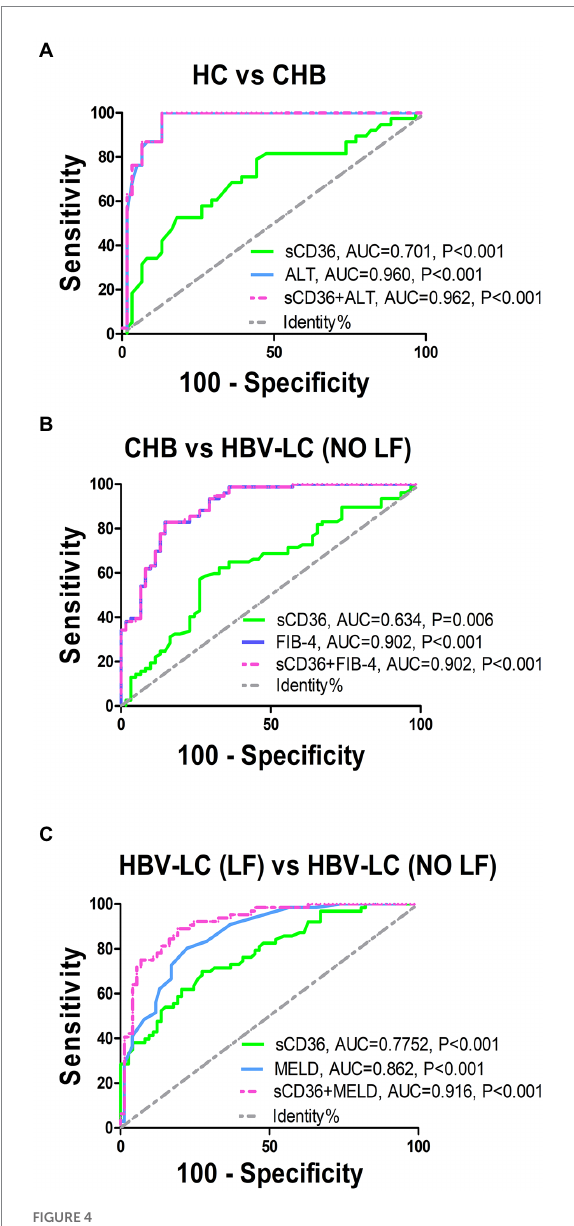
FIGURE 4 Discriminate validity of plasma sCD36 for HBV-related liver diseases with different stages. (A) ROC curves of plasma sCD36, ALT and their combination for discriminating CHB from HCs; (B) ROC curves of plasma sCD36, FIB-4 and their combination for discriminating HBV-LC (NO LF) from CHB; (C) ROC curves of plasma sCD36, MELD and their combination for discriminating HBV-LC (NO LF) from HBV-LC (NO LF); The Youden index was used to maximize the potential effectiveness of the biomarkers. AUC: area under the